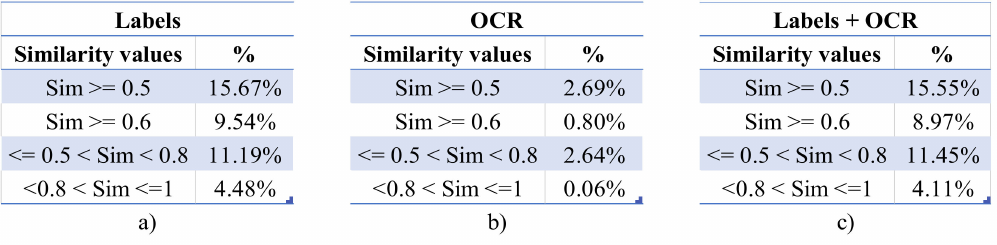
Figure 11. The distribution of cosine similarity values ( a – c ) per type of latent